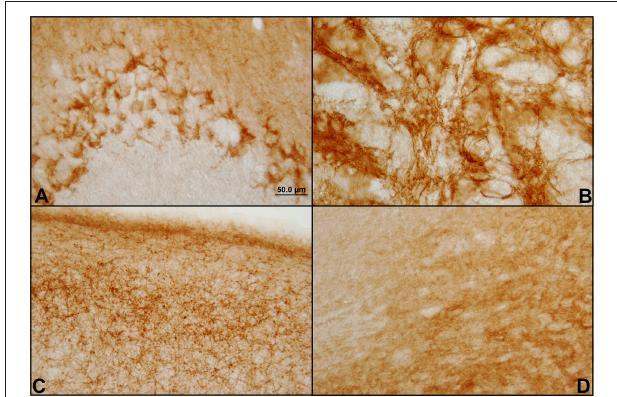
FIGURE 1 | Different patterns of immunostaining of CB1 receptors in the hamster GASH/Sal brain. Immunostaining of CB1 receptors in the brain of GASH/Sal in which a representation of the different staining patterns shown in coronal sections of different brain areas. (A) Dot-like staining surrounding the Purkinje cells bodies of the cerebellum; (B) Network of fibers (reticular staining) in the globus pallidus nucleus; (C) Plexiform staining in the primary motor cortex; (D) Diffuse staining in the substantia